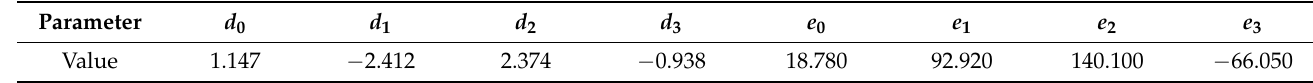
Table 4. Fitting results of the stiffness